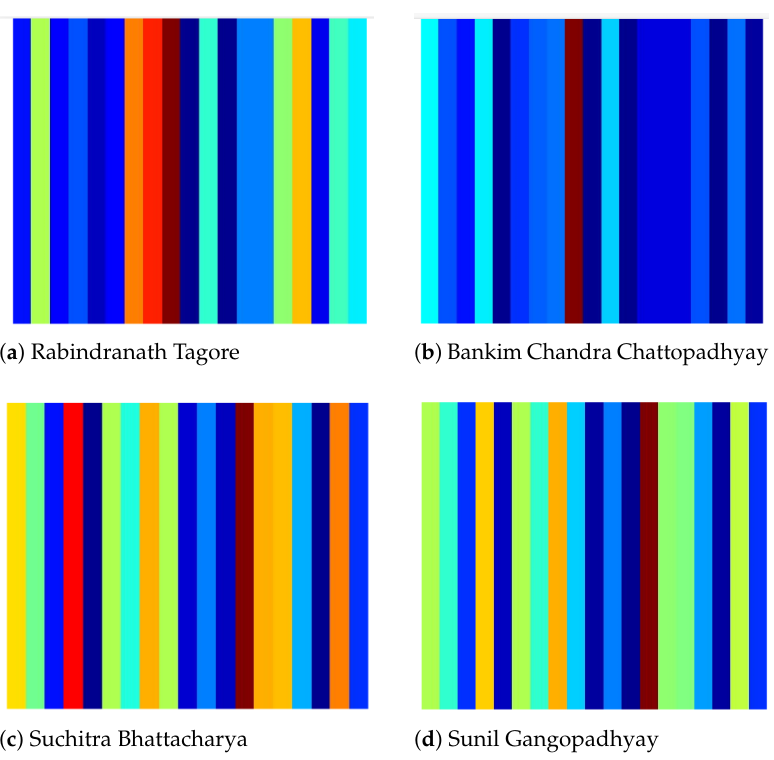
Figure 7. The feature visualizations of one document by four authors using imagesc charts. The x-axis represents the 17 features considered in the experiment. The y-axis represents the feature values obtained for each feature. Here, the “jet” theme was used for distinguishing the feature values from one